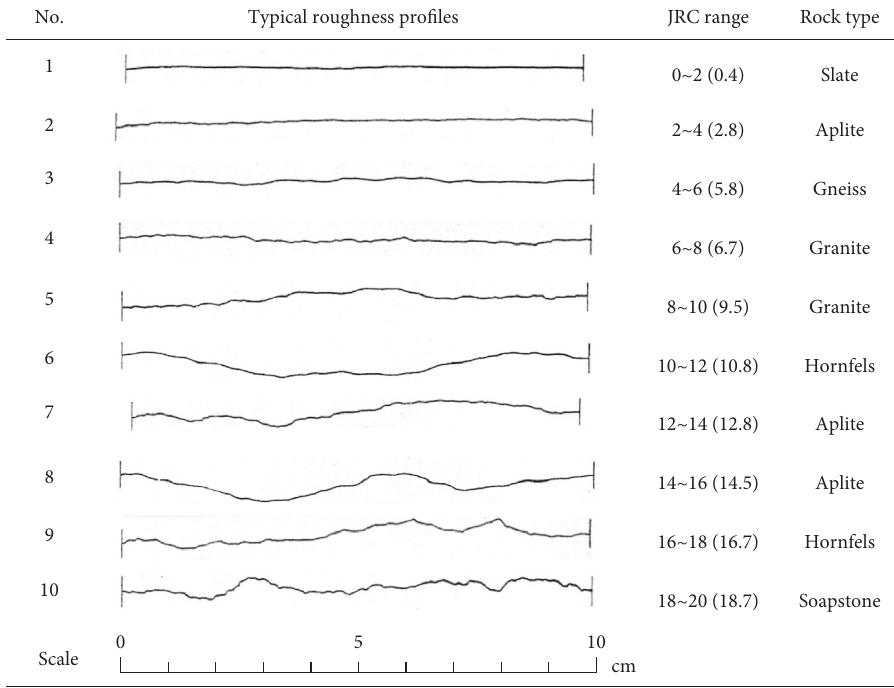
Figure 1: Ten standard roughness joint profiles [10].